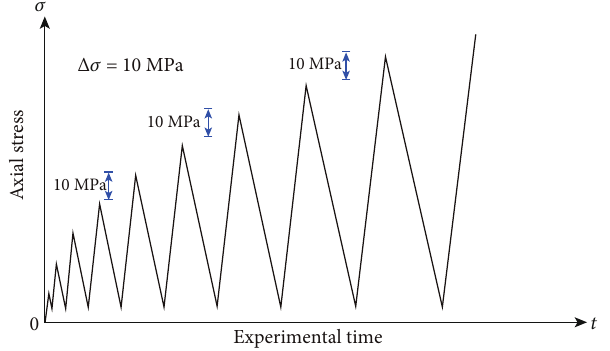
Figure 6: Scheme of the cyclic loading path for increasing amplitude stress-cycling